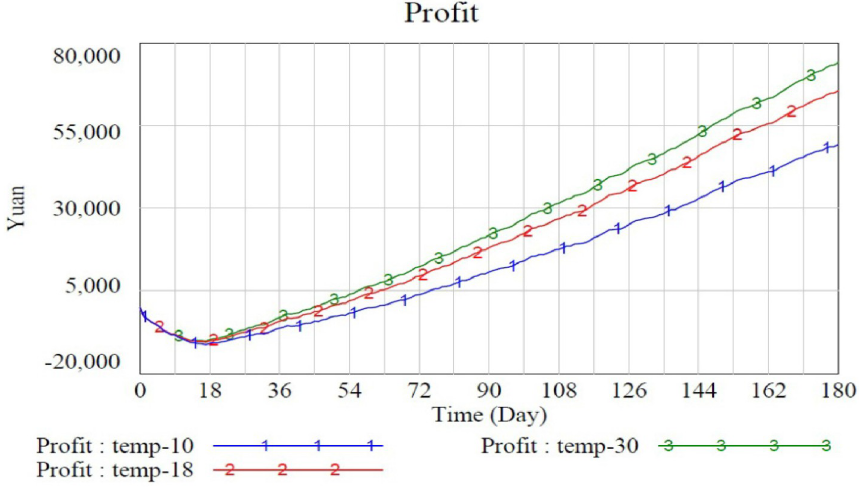
Figure 5. The influence of different temperature against